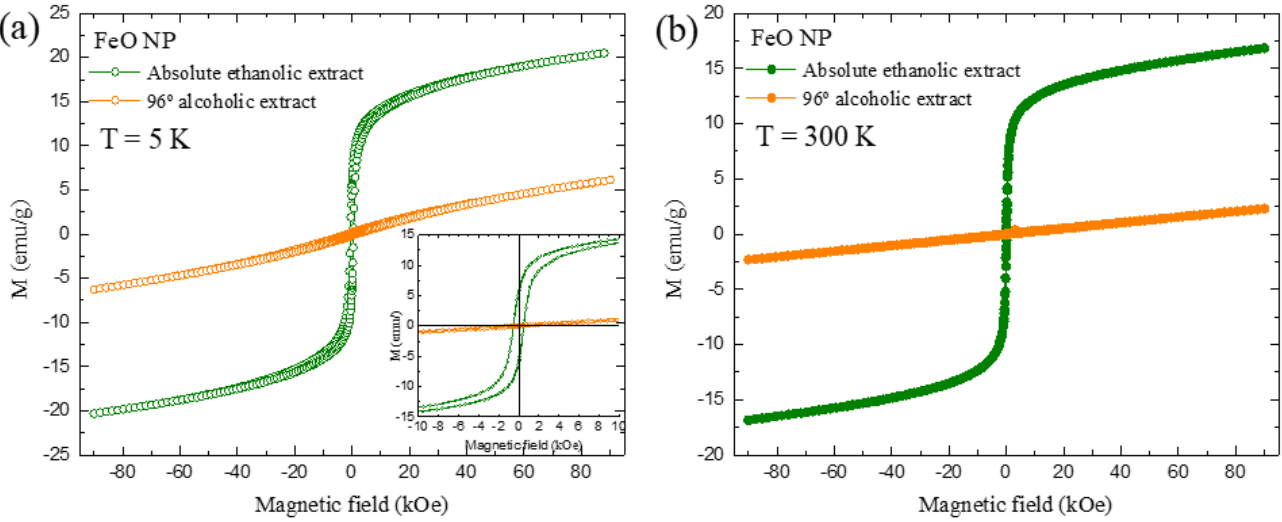
Figure 9. Measurements of saturation magnetization versus applied field hysteresis for FeO NP using extracts in ethanolic and alcoholic solvents ( a ) 5 K, ( b ) 300 K.